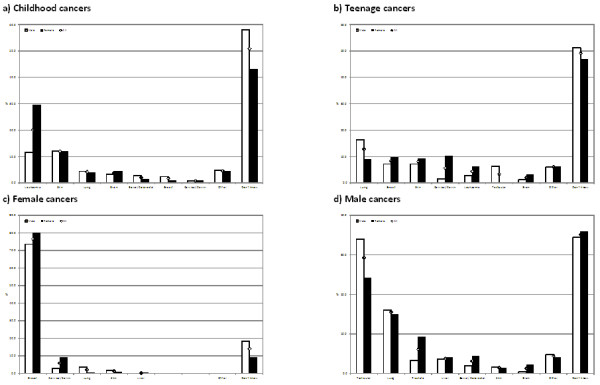
Perceptions of childhood, teenage and female/male cancers by gender. a) Childhood cancers b) Teenage cancers c) Female cancers d) Male cancers.